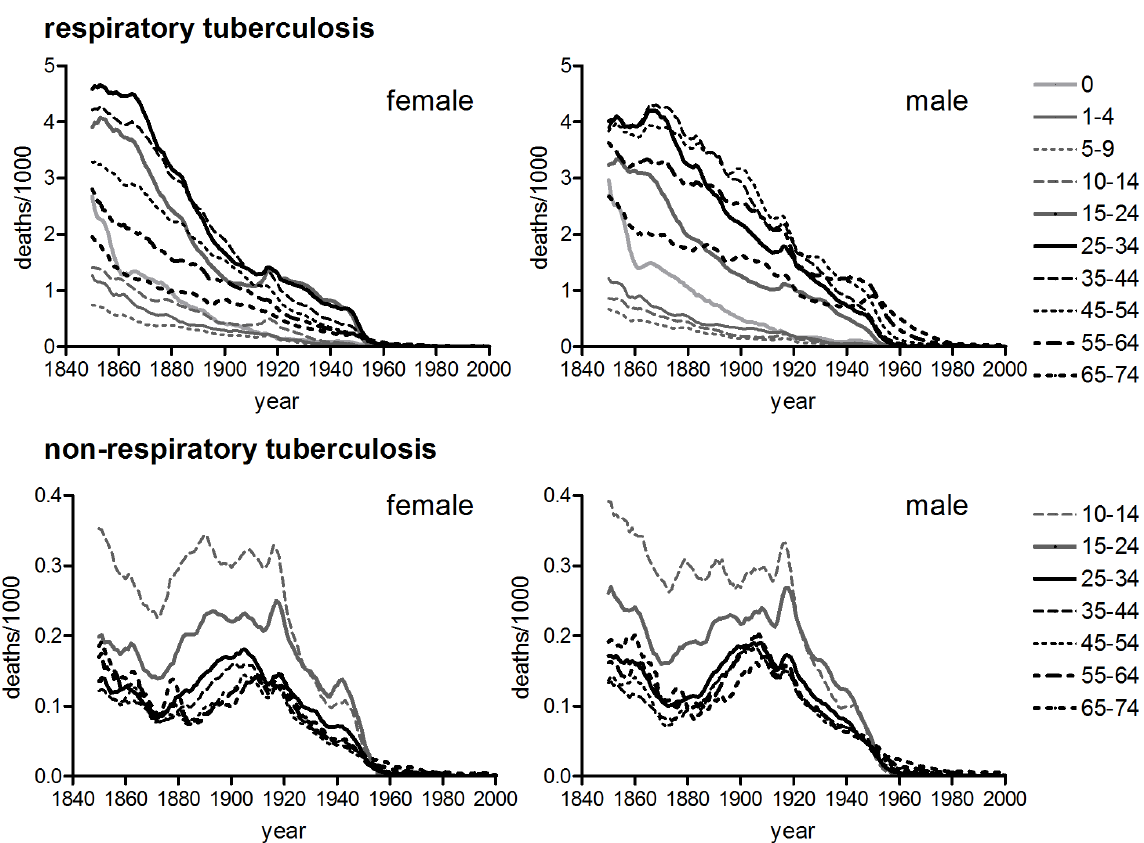
doi:10.1371/journal.pone.0081797.g006